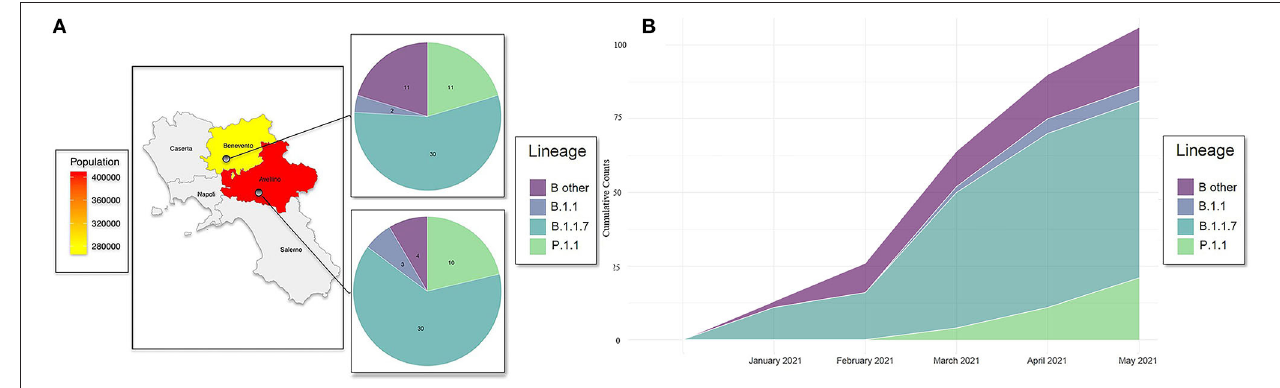
FIGURE 1 | (A) Geographic distribution of COVID-19 cases, lineages detected, and population density among two provinces of Campania: Avellino and Benevento. (B) Distribution of SARS-CoV-2 genomes against collection date and lineages. Cumulative counts of the 101 SARS-CoV-2 genomes spreading in districts of Benevento and Avellino against collection date. Lineage “B 1.1” refers to haplotype B: B.1.1.351 and B.1.1.374. “B other” refers to B.1.177.53, B.1.177.75, B.1.177, B.1.258.14, B.1.258.17, and B.1.160.